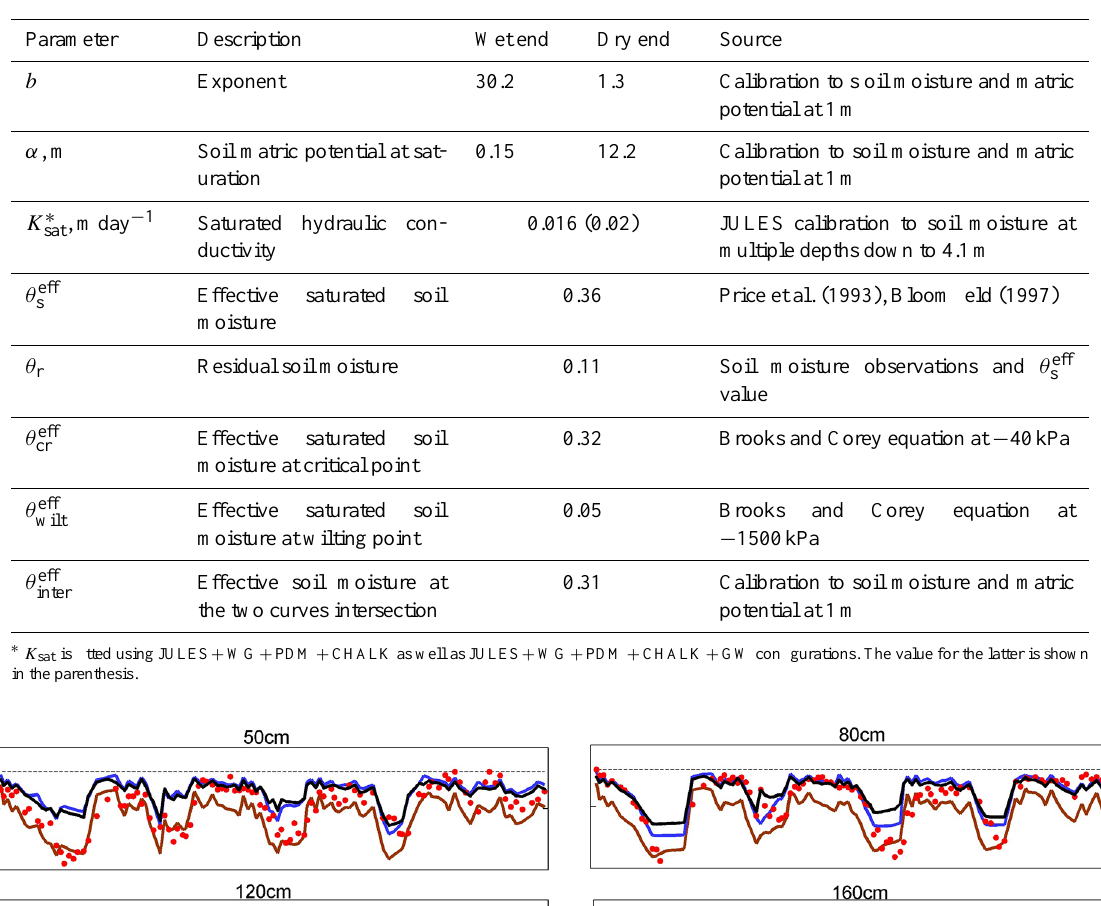
Table 4. Hydraulic double Brooks and Corey curve parameters for chalk.